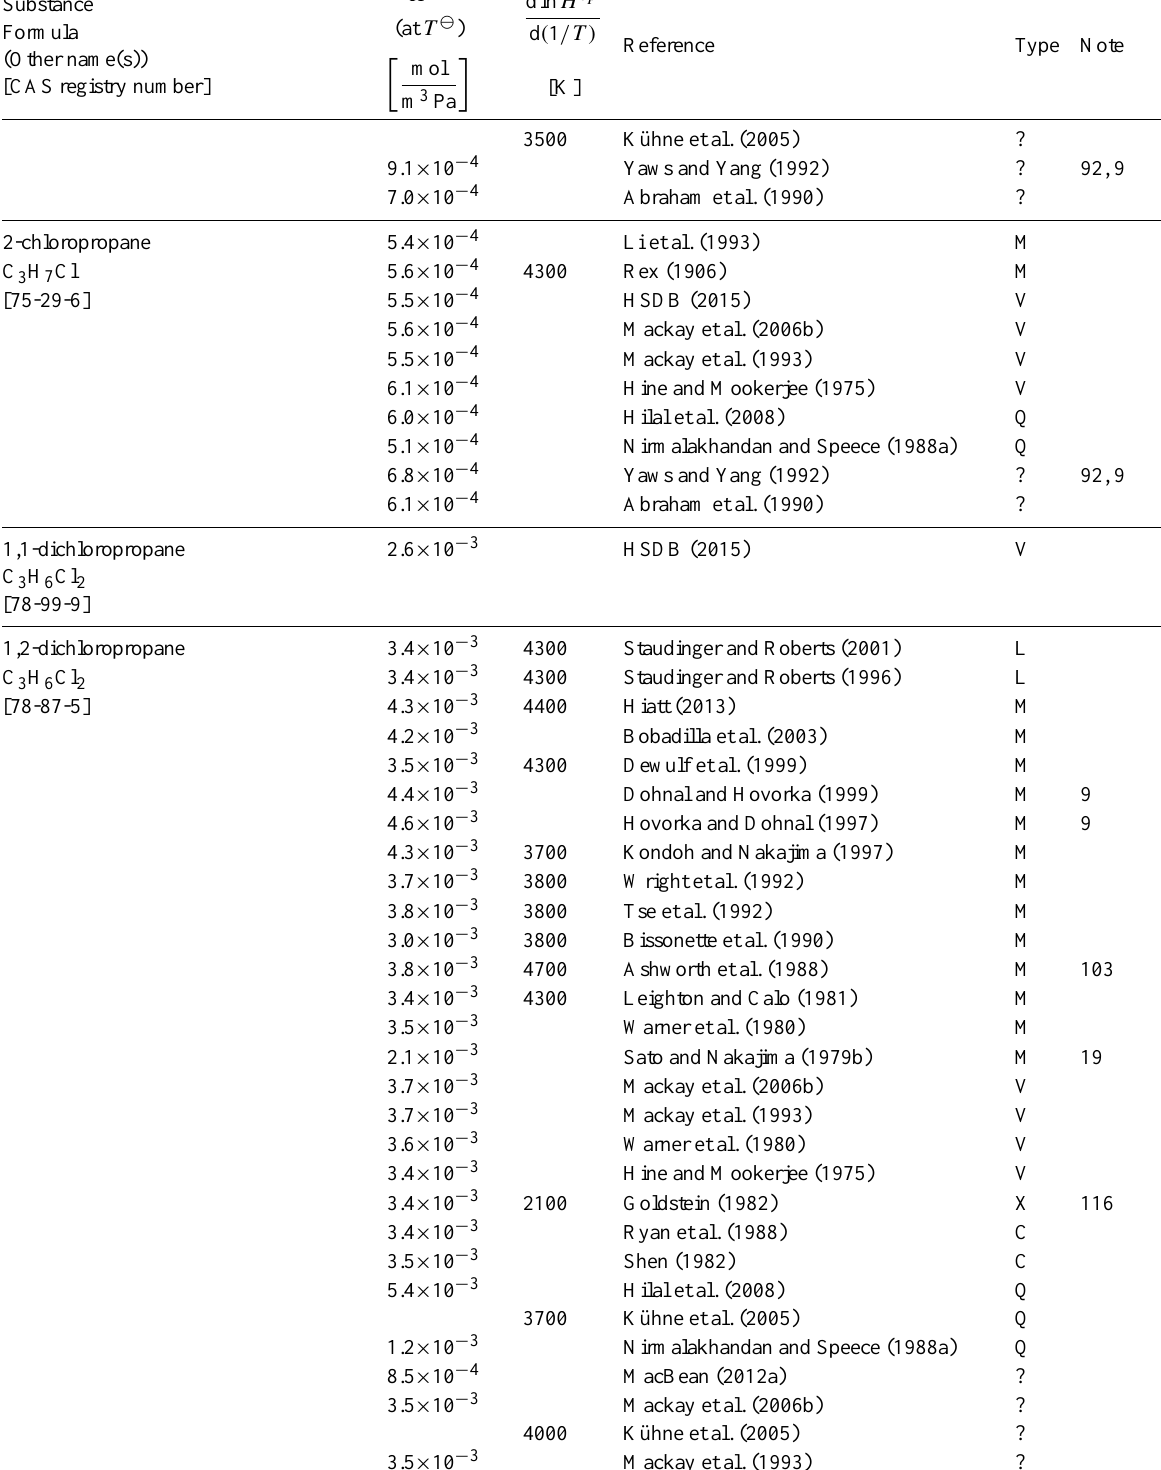
Table 6: Henry’s law constants for water as solvent